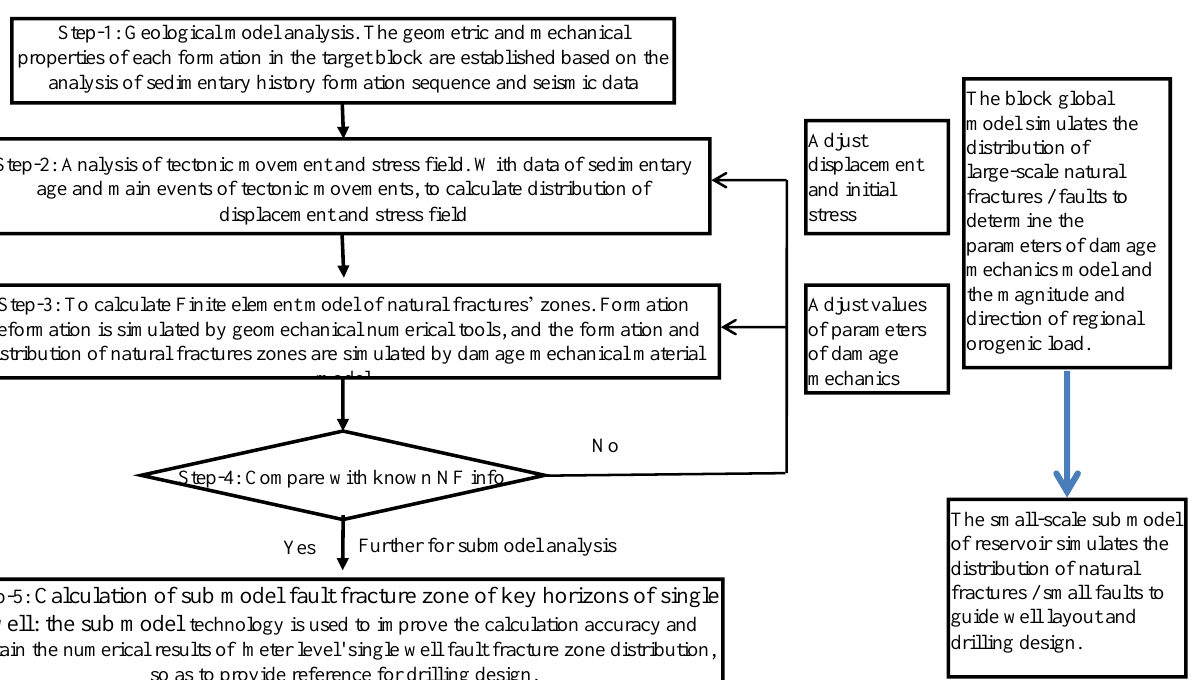
Figure 1. Flow chart of forward modeling of plastic damage calculation for natural fractures (NF) generated by tectonic movement.